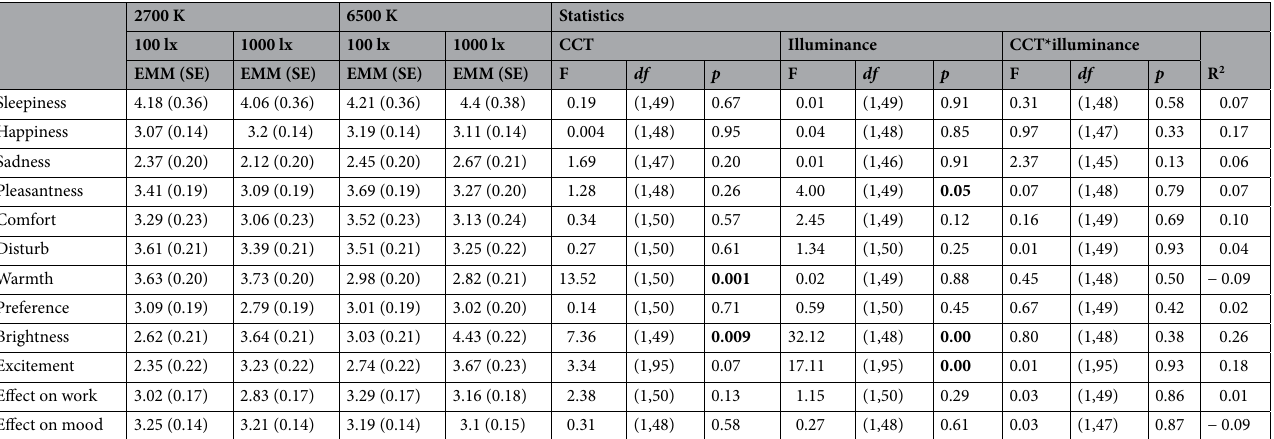
Table 3. Results for subjective measures (sleepiness, mood, evaluation of lighting conditions). EMM estimated marginal means, SE standard errors. A significant difference is indicated by bold